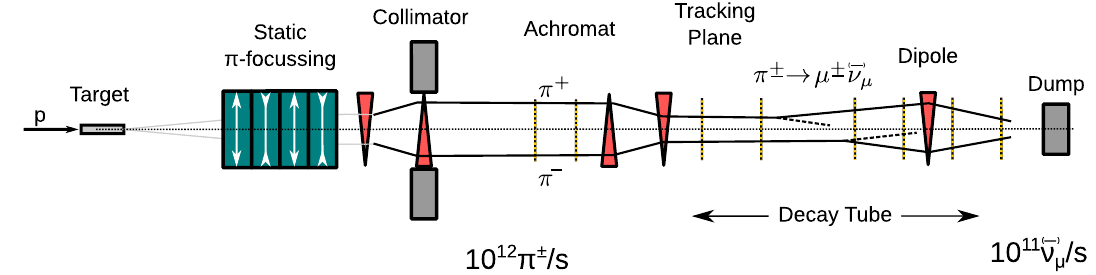
Fig. 1 Schematic of a possible beam line enabling neutrino tagging. Blue rectangles represent quadrupoles, red triangles dipoles and vertical dotted lines correspond to tracking planes. The number and location of those are not optimised. The schematic is described in more details in the